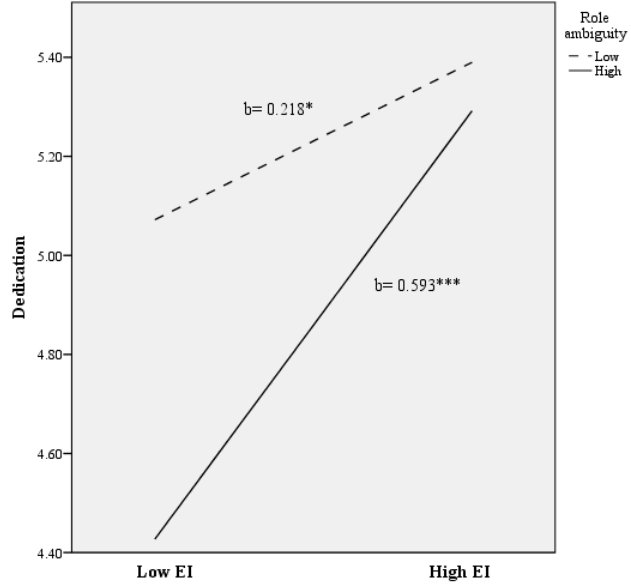
Figure 2. The relationship of Emotional Intelligence and role ambiguity for predicting dedication scores. Note: EI = Emotional Intelligence. * p < 0.050; *** p <